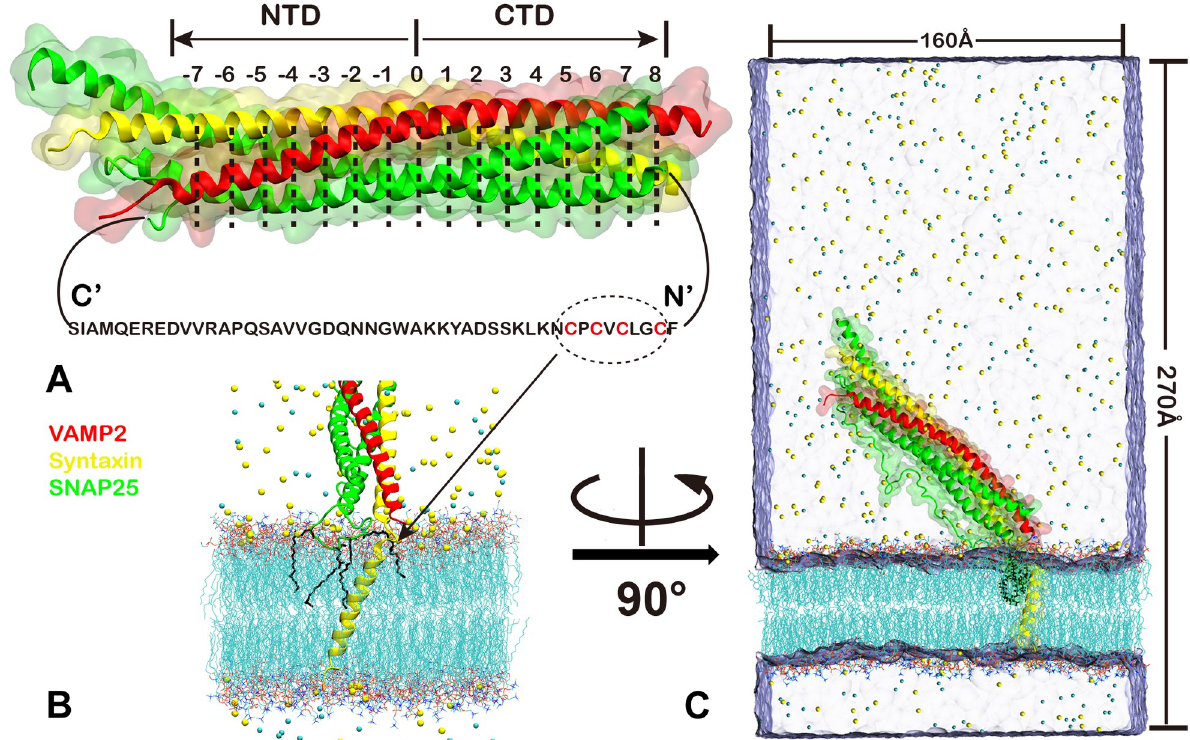
Fig 1. SNARE complex and the simulation setup. (A)Schematic of ternary SNARE four helix bundlewith Syntaxin(yellow), VAMP2 (red), SNAP25(green). The notation of SNARE layers is indicated. The sequenceof linker loop of SNAP25 is shown, 4 palmitoylated cysteines anchored to the membranewere shown in red. (B)Assembly of SNARE complex with the membrane, with the palmitoylated cysteines on SNAP25 highlighted.(C)The initial simulaitonsystem. The SNARE core domain is placed ~ 40˚ reletive to the